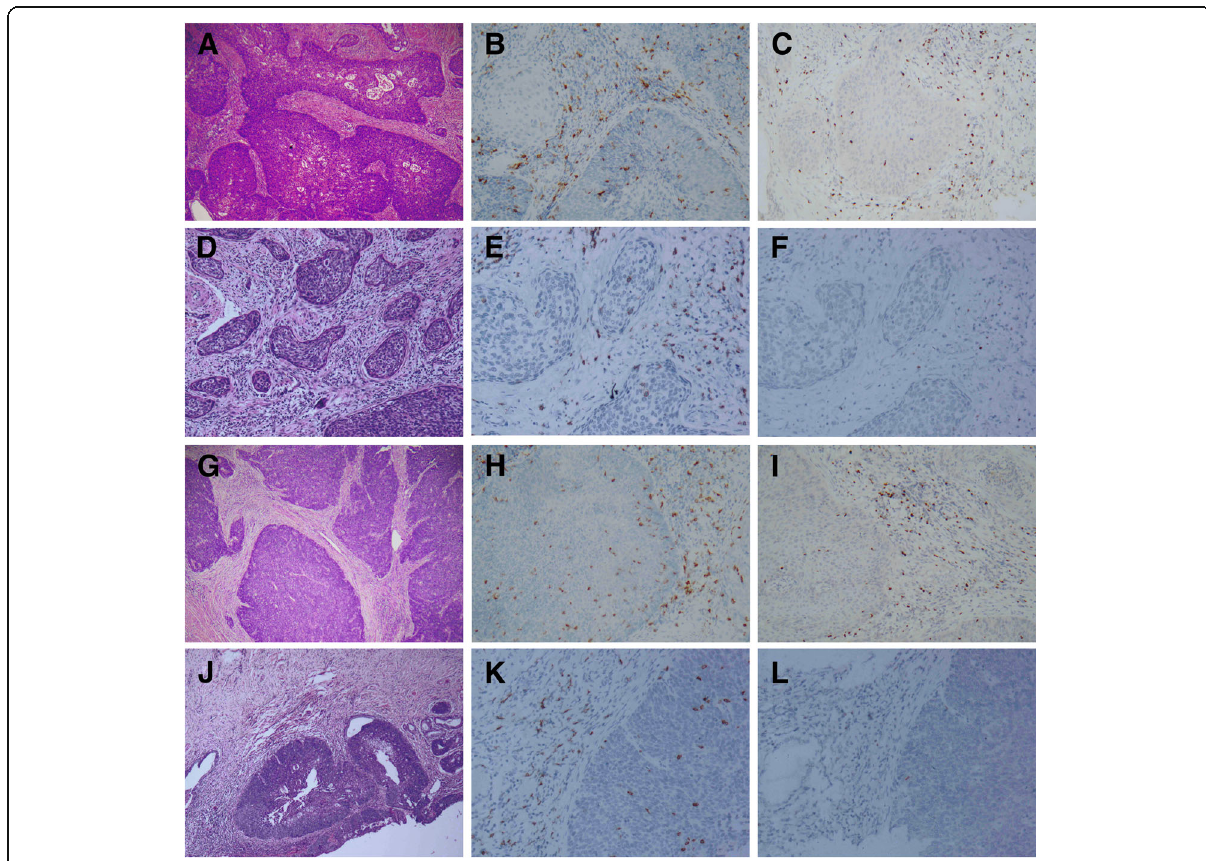
Fig. 1 CD8+ and Foxp3+ T cells in cervical cancer before and after NACT. A pre-chemotherapy biopsy showed a typical morphology of squamous cell carcinoma ( a ). The tumor had higher CD8+ T cells ( b ) and Foxp3+ cells ( c ) in the surrounding tissue than those in the tumor nests. After NACT, the tumor didn ’ t achieve pathological complete response, which harbors sparse tumor nests in the stroma ( d ). Foxp3+ T cells decreased significantly ( e ), while CD8+ cells remained stable ( f ). In another case with pathological complete response, pre-chemotherapy biopsy was characteristic of squamous cell carcinoma ( g ). Both CD8+ T cells ( h ) and Foxp3+ cells ( i ) were higher in the surrounding tissue than those in the tumor nests. After NACT, the tumor only had a component of residue carcinoma in situ ( j ). CD8+ cells were not significantly changed ( k ), while Foxp3+ T cells were almost undetectable ( l